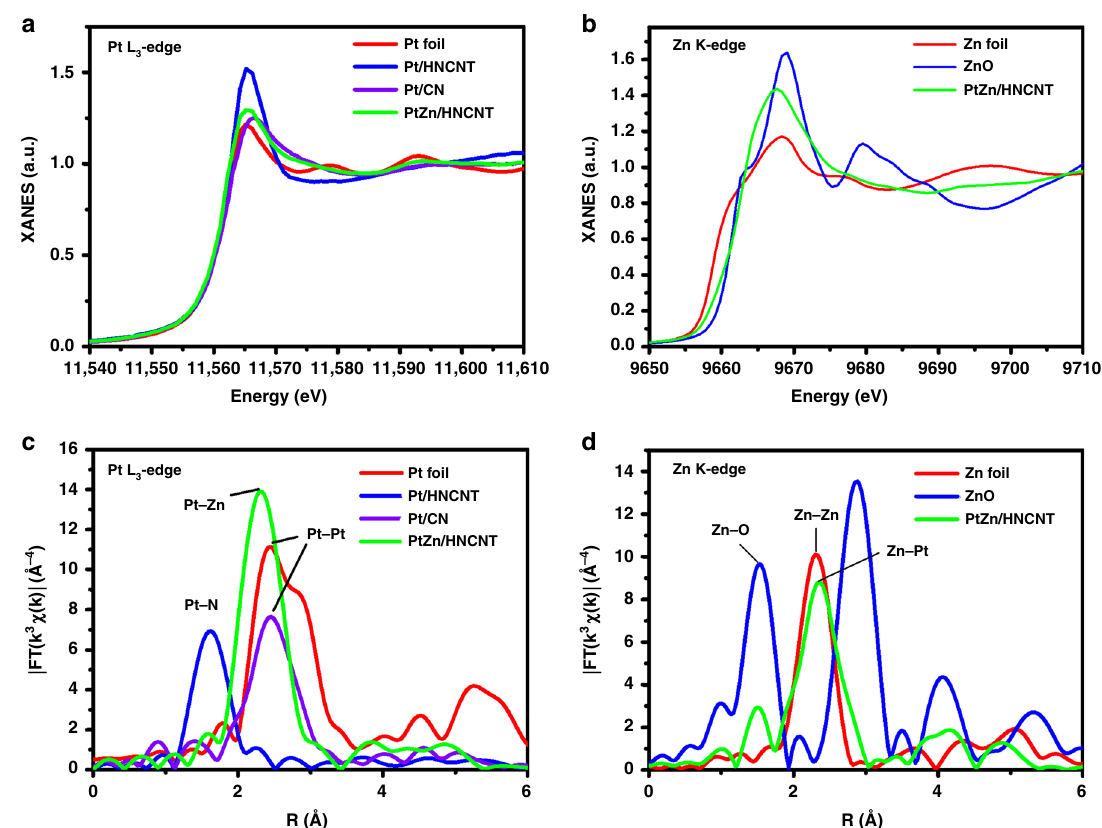
Fig. 2 X-ray absorption spectroscopy characterization of the catalysts. a , c The normalized X-ray absorption near-edge structure (XANES) spectra ( a ) and Fourier transform extended X-ray absorption fi ne structure (FT-EXAFS) ( c ) at the Pt L 3 -edge of the PtZn/HNCNT, Pt isolated-single-atomic-site supported on hollow nitrogen-doped carbon nanotubes (Pt/HNCNT), Pt nanoparticles supported on nitrogen-doped carbon nanospheres (Pt/CN) and Pt foil. b , d The normalized XANES spectra ( b ) and FT-EXAFS ( d ) at the Zn K-edge of the PtZn/HNCNT, ZnO and Zn